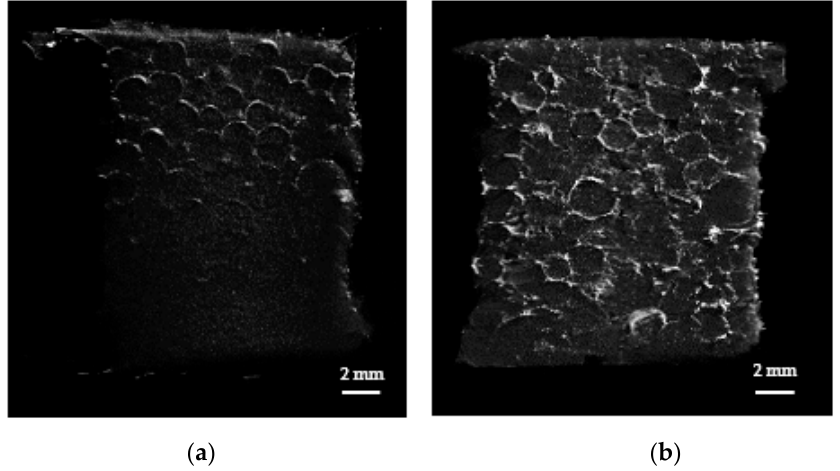
Figure 5. Permeability of gel bed packed with ( a ) SAPS and ( b ) AgNP-SAPs. Severe gel blocking was only observed in SAP-packed mold, while AgNP-SAPs showed good permeability.